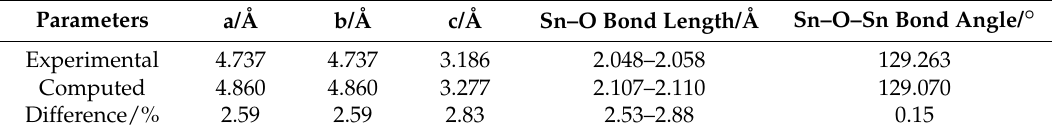
Table 3. Computed and experimental cassiterite lattice parameters.